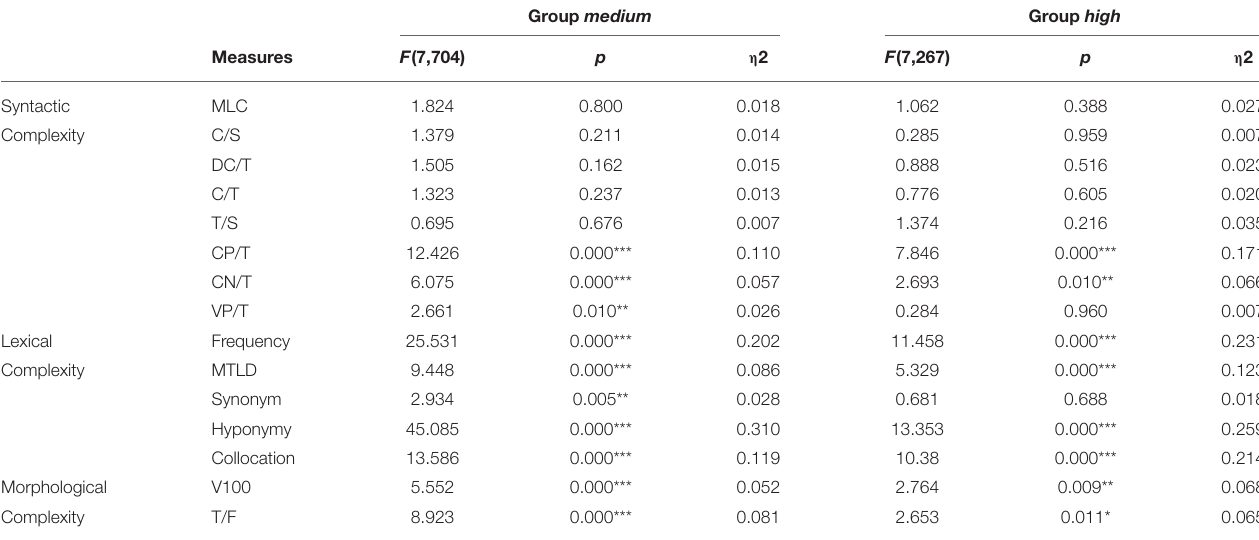
TABLE 7 | Topic effects and effect sizes (within-groups).